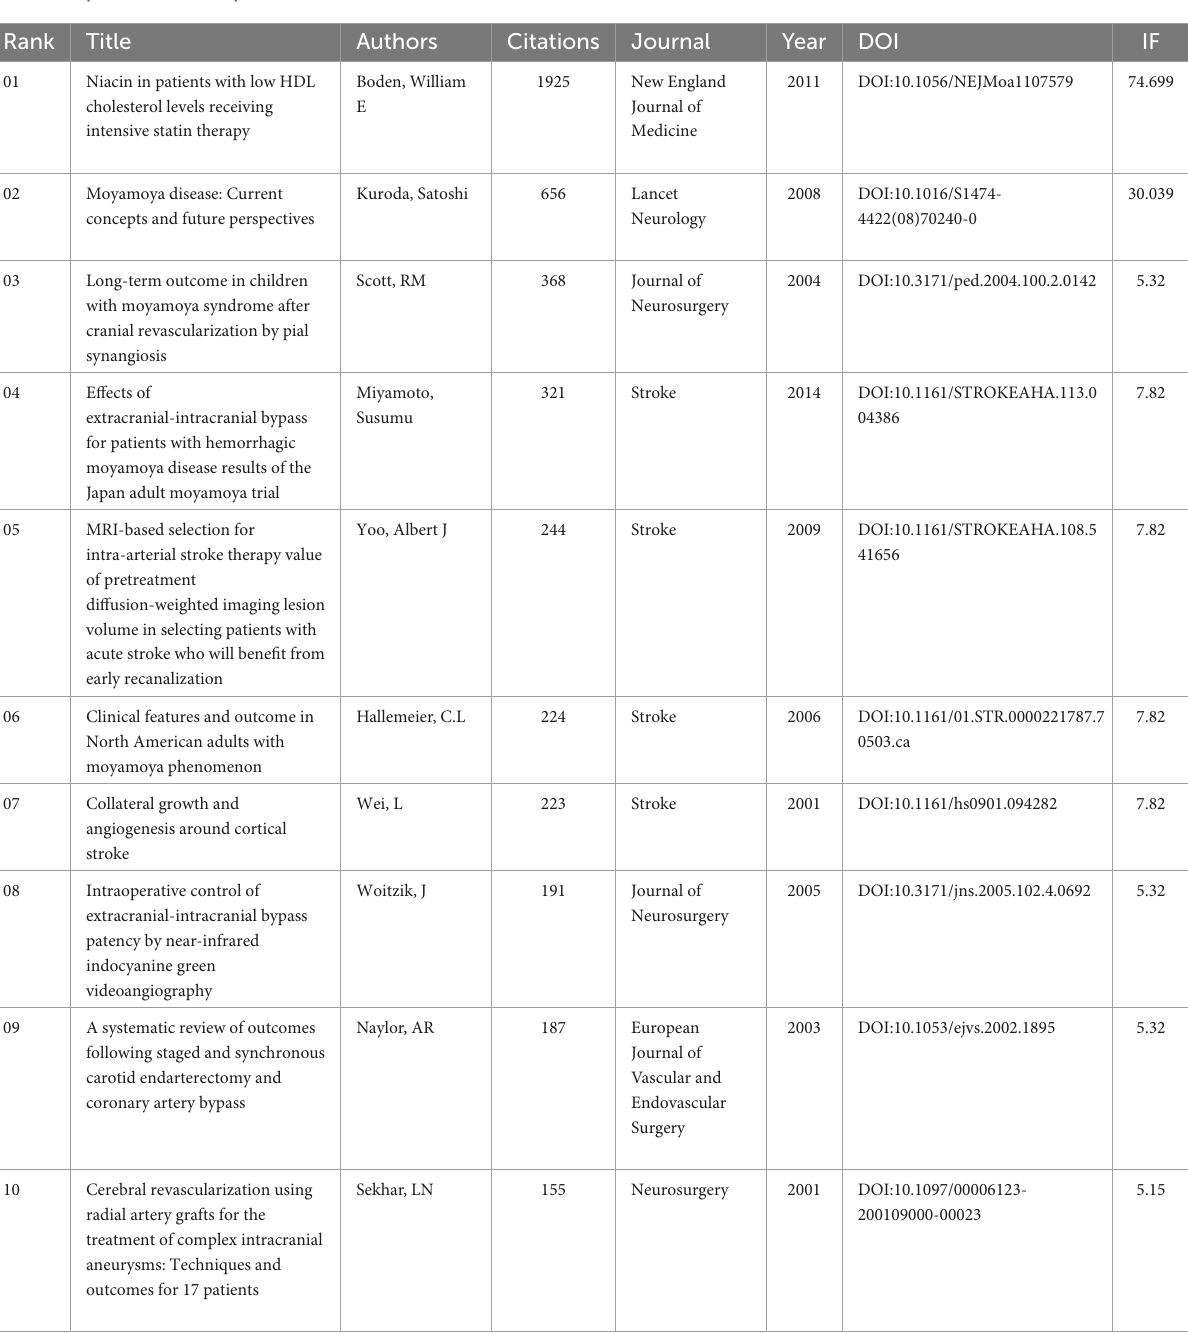
TABLE 9 Top cited articles (top